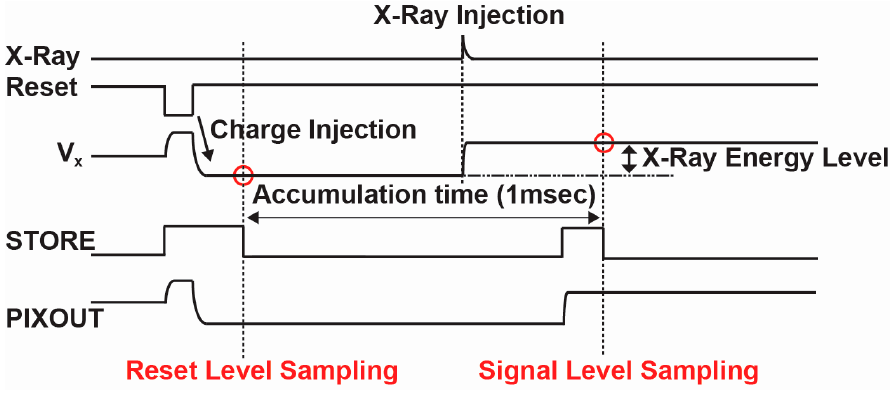
Figure 10. Pixel Timing Diagram.